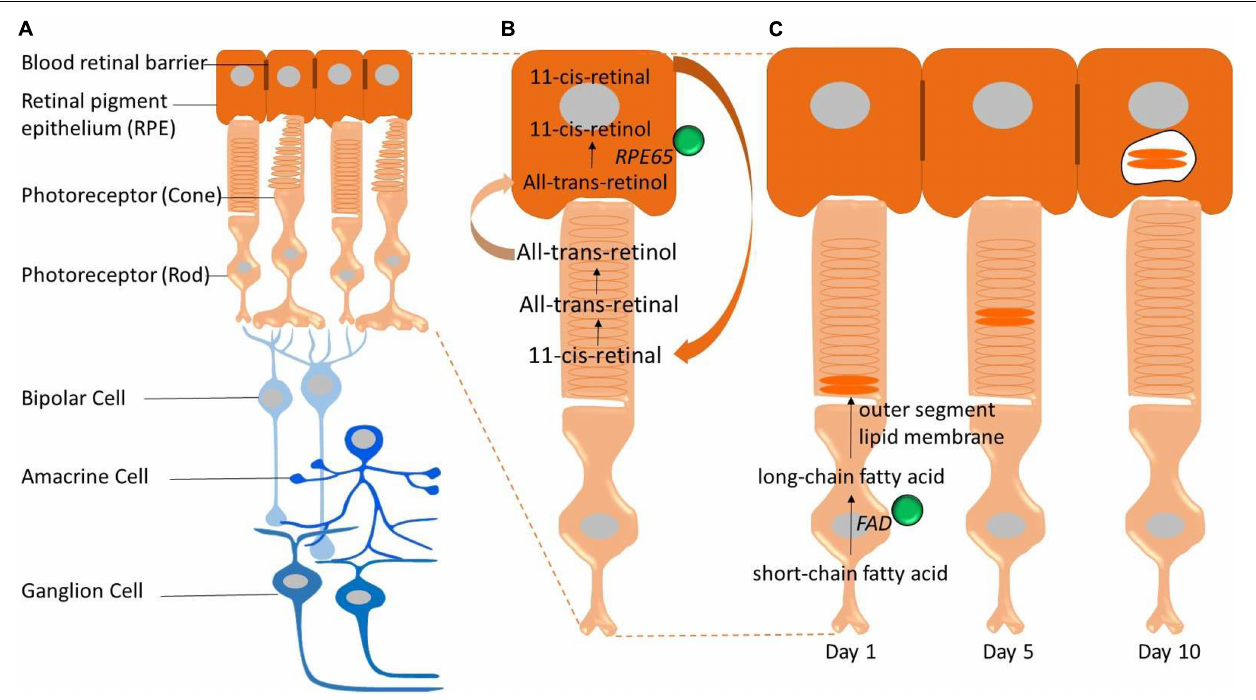
FIGURE 1 | Schematic representation of the retina and key pathways that involve iron (iron represented by green spheres). (A) The neural retina is isolated from the bloodstream (choroidal vessels) by the blood–retinal barrier. The outer blood–retinal–barrier is formed by tight junctions located between the retinal pigment epithelium (RPE). Photoreceptors convert light into electrical signals through the visual cycle and these electrical signals are communicated through the retina via the bipolar and ganglion cells. (B) Iron is required for the visual cycle. Regeneration of 11-cis-retinal, the chromophore of visual pigments in photoreceptor cells, is essential for vision and depends on an earlier reaction catalyzed by the iron-containing isomerase, retinal pigment epithelium-specific 65 kDa protein (RPE65). (C) Photoreceptor outer segments (rods and cones) are constantly synthesized and shed. This process is highly dependent on fatty acid desaturase (FAD) enzyme which is iron dependent to synthesize new membrane lipids.